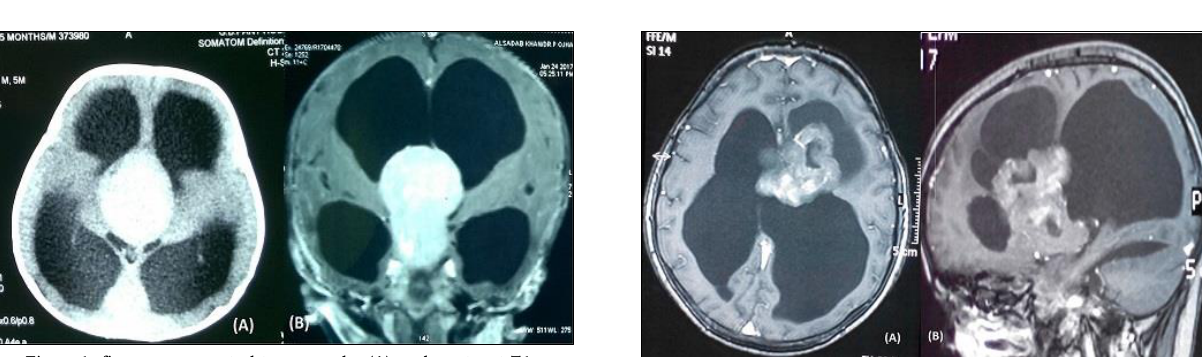
Figure1: figures, computed tomography (A) and contrast T1- weighted magnetic resonance image (B) of a 4 months old child showing a tumor in suprachiasmatic region extending into third ventricle, which is homogeneously contrast enhancing. These radi- ological features are suggestive of optico-chiasmatic glioma.